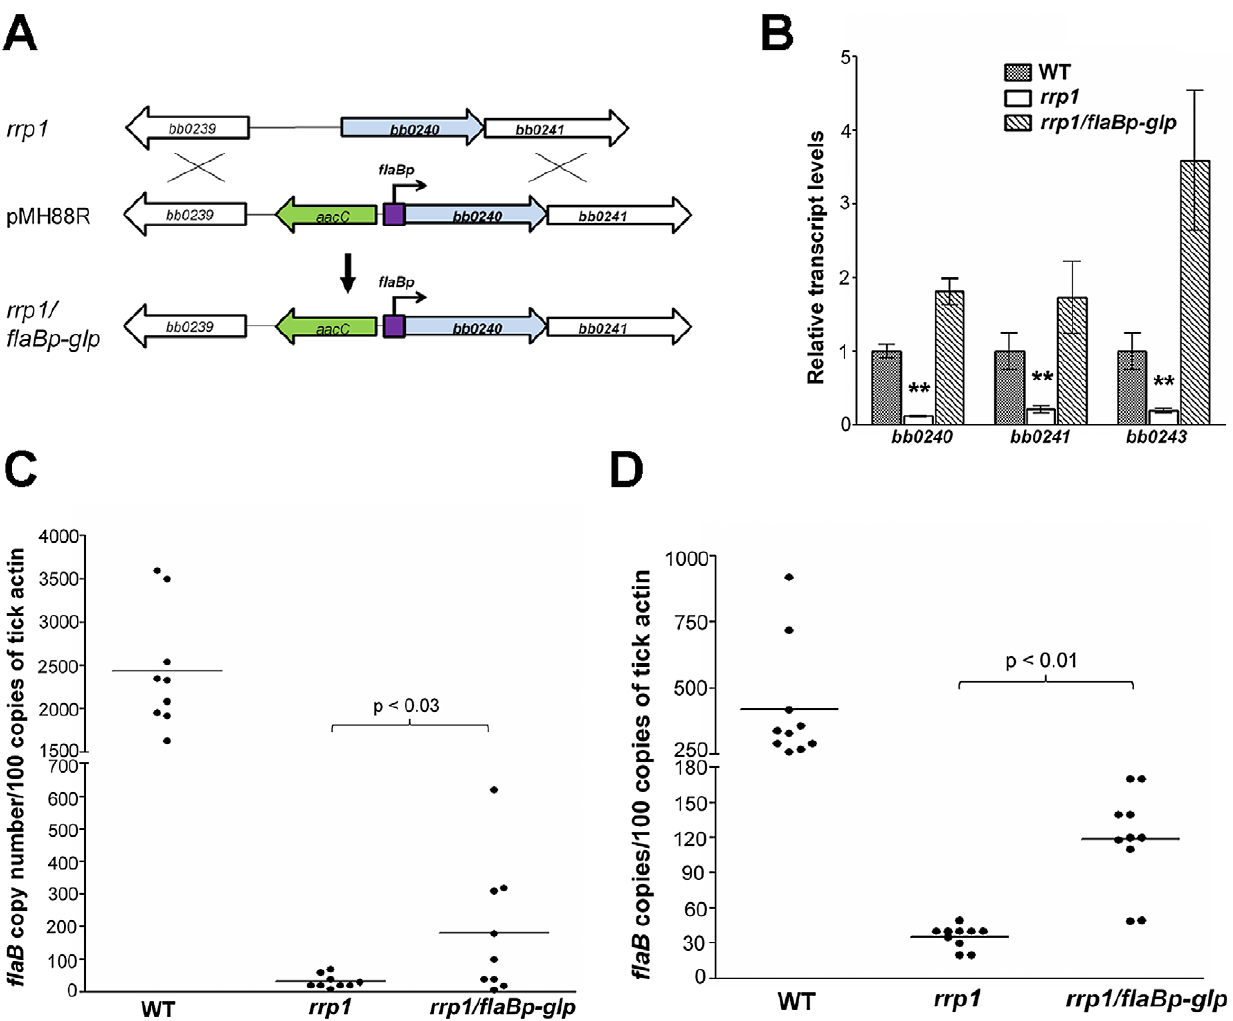
Figure 8. Constitutive expression of glycerol metabolism genes in the rrp1 mutant partially restored spirochetal survival in ticks. ( A ) Strategy for construction of an rrp1 mutant with constitutive expression of bb0240-bb0243 , by replacing the promoter region of bb0240 with the flaB promoter. ( B ) Real-time RT-PCR analysis of expression of b0240, bb0241 , and bb0243 . RNA was isolated from late logarithmic phase cultures of wild- type (WT), the rrp1 mutant ( rrp1 ), or rrp1/flaBp-glp that had been grown at 35 u C in the BSK-II medium (pH 7.5). Levels of gene expression were normalized with the level of flaB gene expression. Fold changes of gene expression relative to wild-type strain (set as 1) were reported. ( C ) and ( D ), qPCR analysis of spirochetal burden in fed larvae one day ( C ) or fourteen days ( D ) after repletion. Copies of the B. burgdorferi flaB genes were chosen to represent spirochete numbers and are normalized with 100 copies of the tick actin gene in each sample. Each data point is from three fed larval ticks. **, p , 0.01.